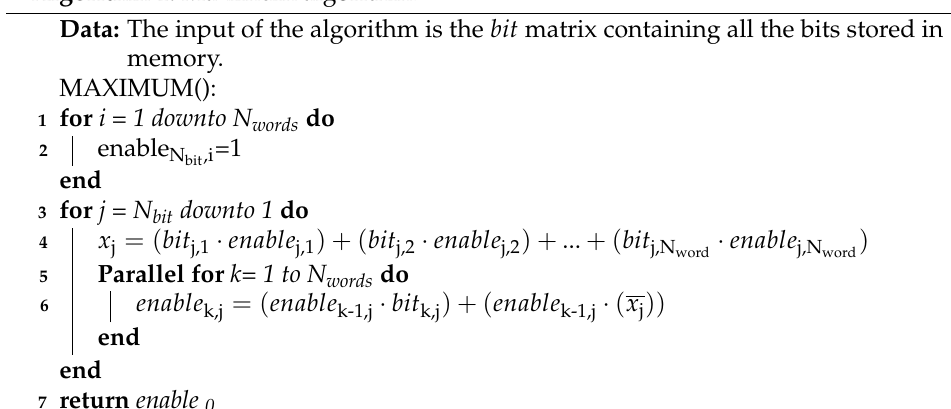
Algorithm 1: Maximum algorithm.